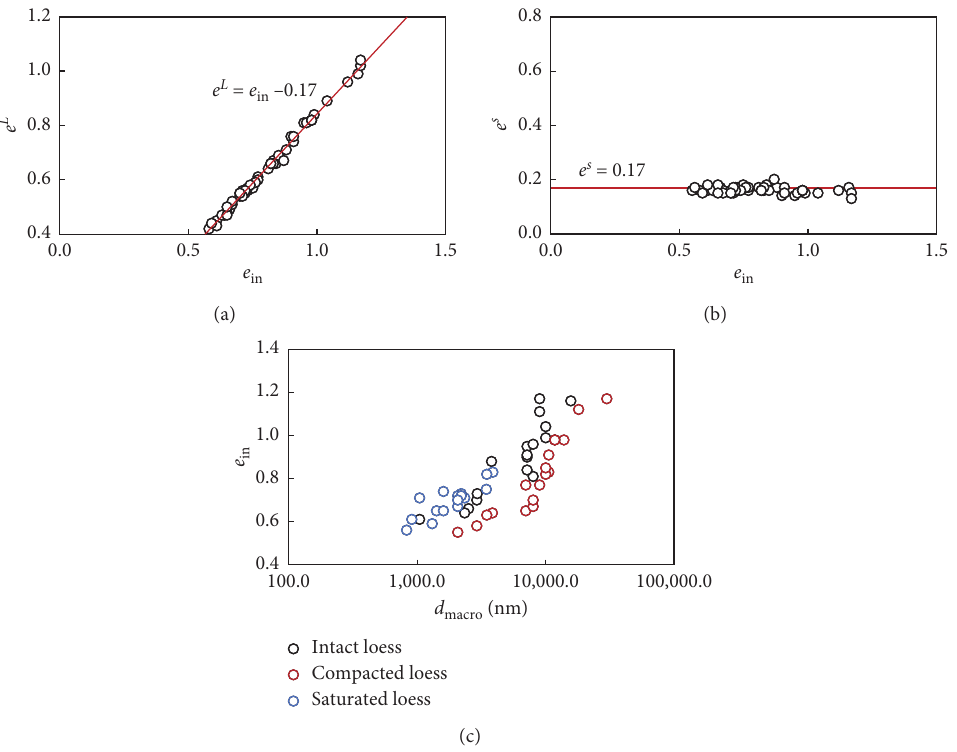
Figure 14: Relationship between (a) e